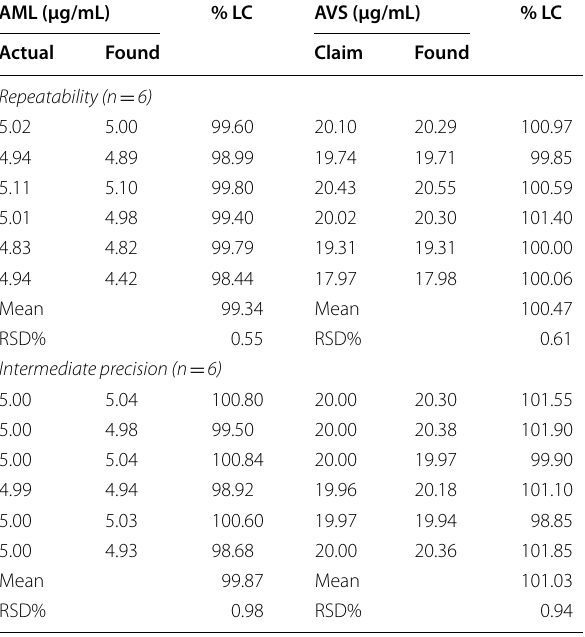
Table 7 The precision of the multiwavelength regression method